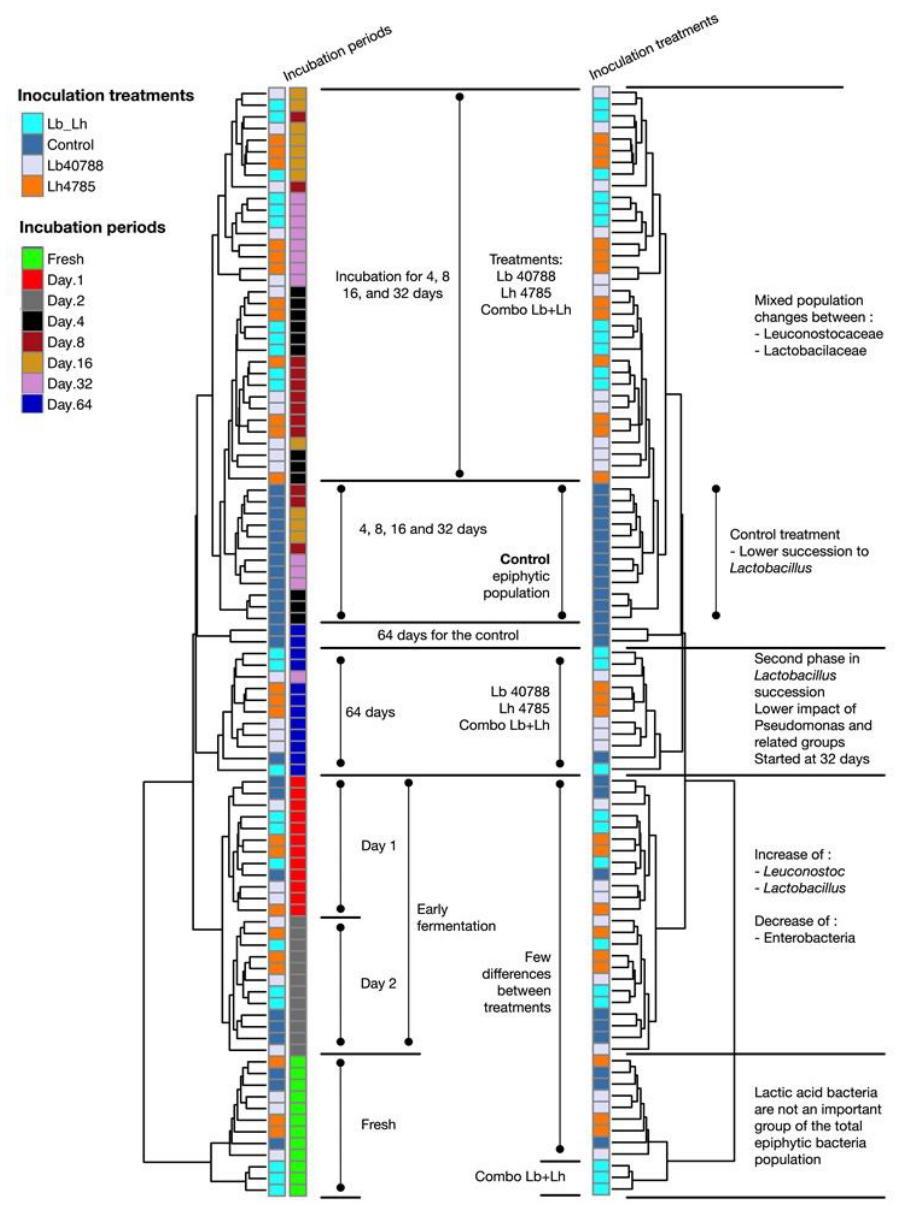
Figure 2. Main variations in Eubacteria diversity using the UPGMA dendrogram generated for analysis of the heatmap (see Figure S2).